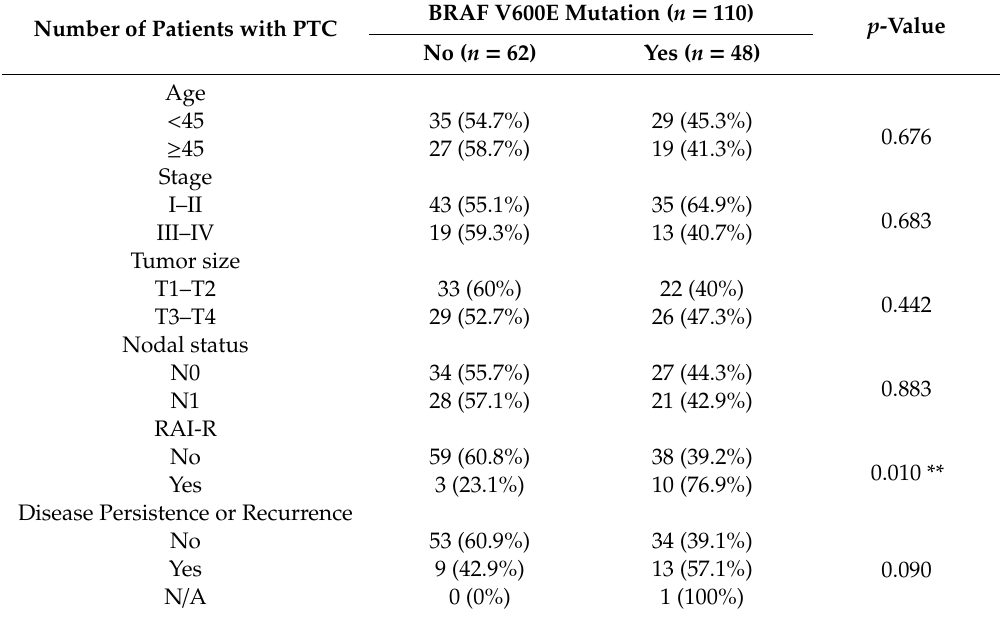
Table 2. Relation between v-raf murine sarcoma viral oncogene homolog B (BRAF) mutation status and clinico-pathologic features in the group of 110 patients. RAI-R = Radioactive Iodine-Refractoriness. ** p ≤ 0.01.